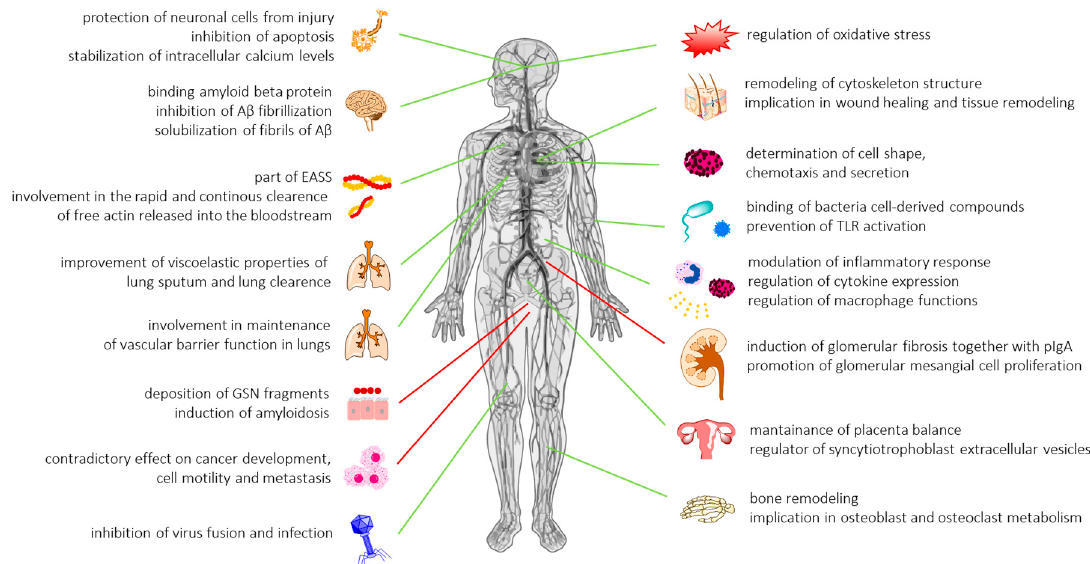
Figure 1. The implications of extracellular gelsolin in a variety of physiological and pathological processes. Green arrows indicate the beneficial effect of gelsolin in the maintenance of health and physiological balance; red arrows indicate disadvantageous gelsolin-mediated events.